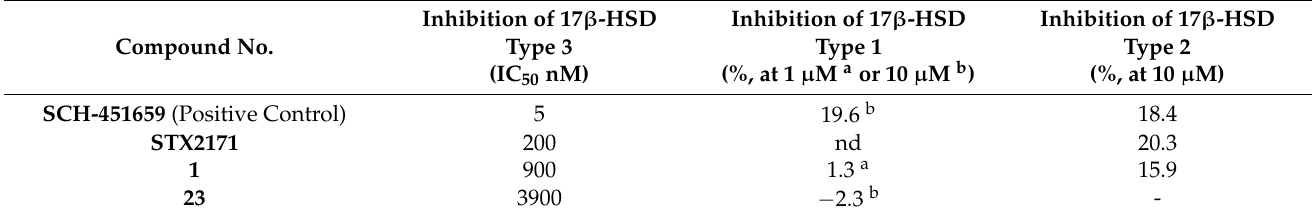
Table 10. Selectivity of some 17 β -HSD Type 3 inhibitors against 17 β -HSD Type 1 and Type 2.